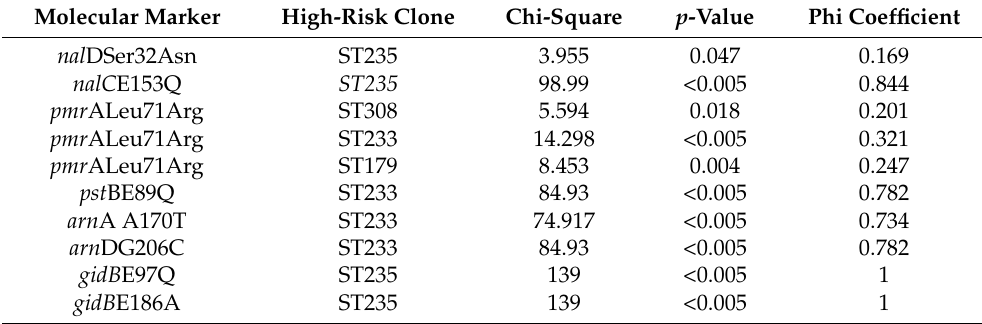
Table 4. Gentamycin molecular markers showing significant associations with specific high-risk clones. Molecular